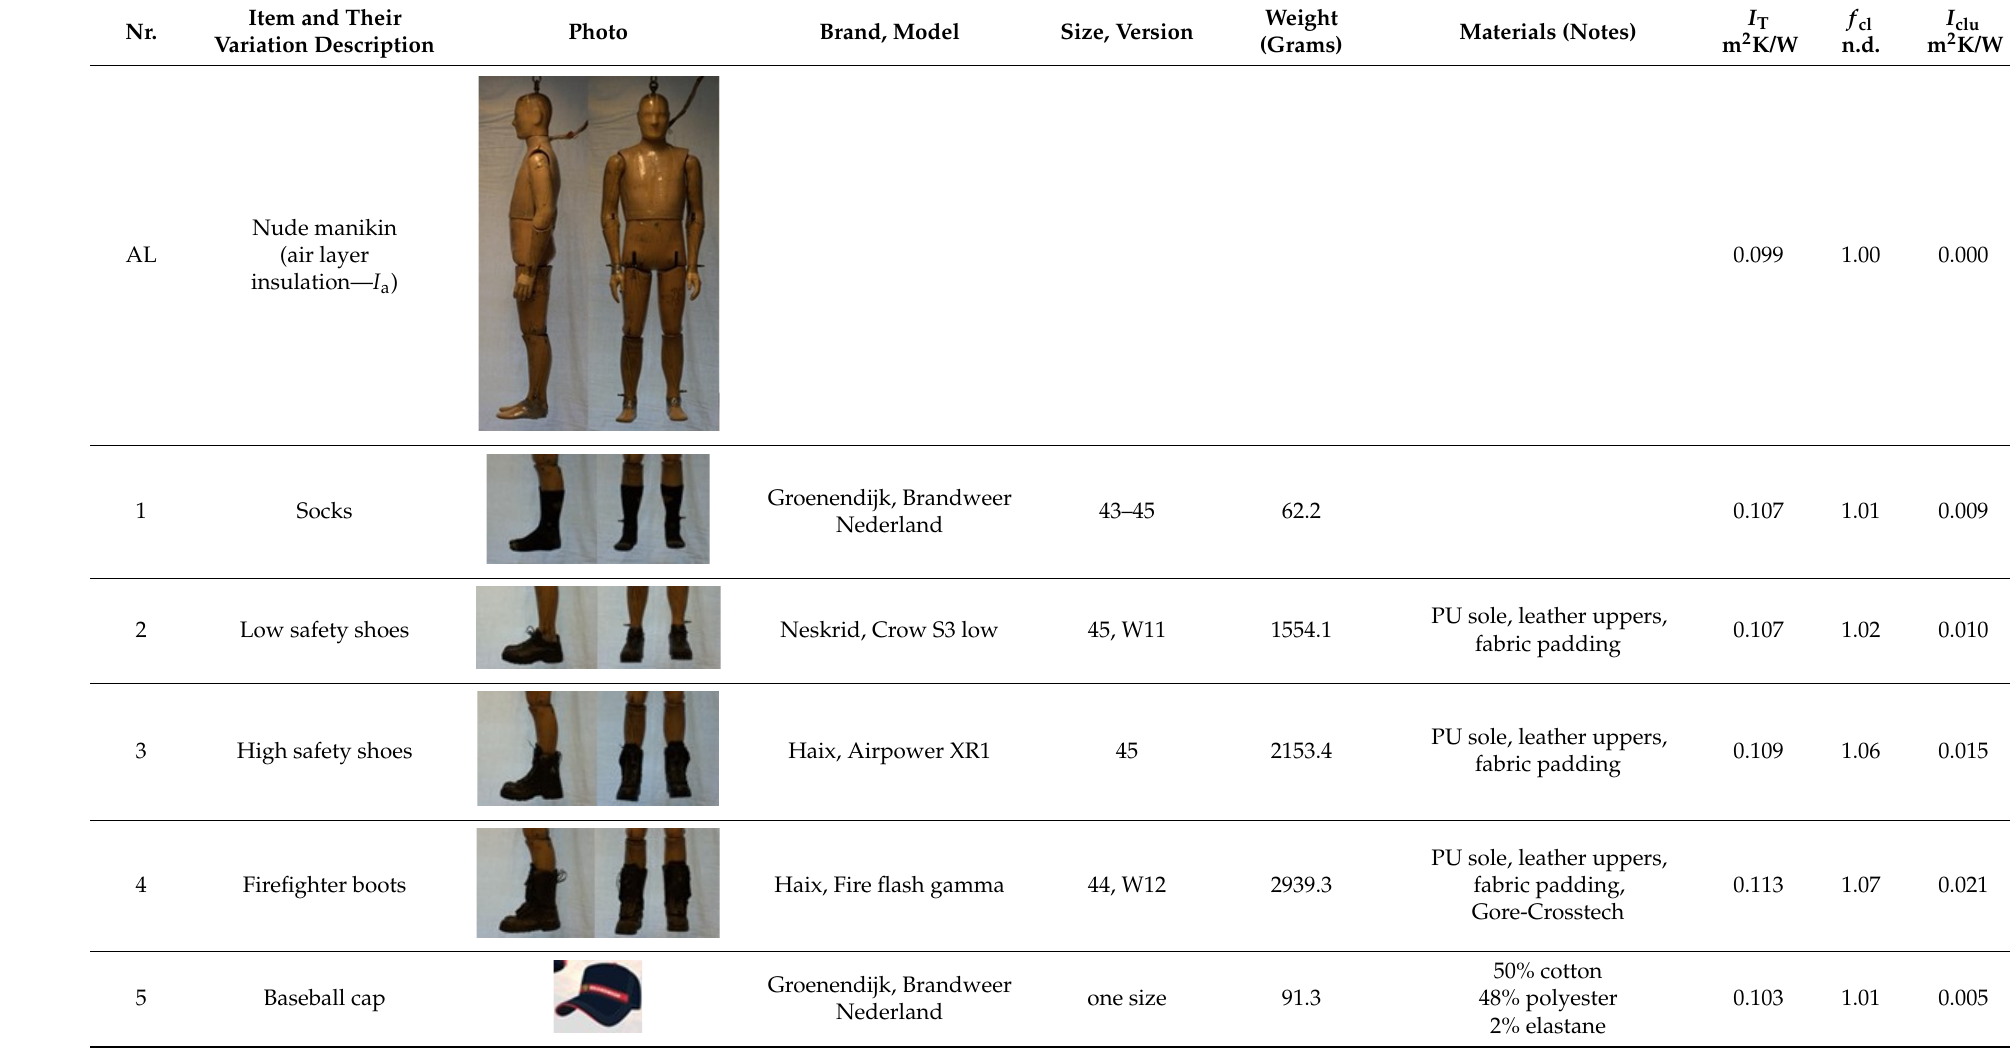
Table 1. Clothing item specifications and their total insulation ( I T ), clothing area factor ( f cl ) and basic clothing insulation ( I clu ).